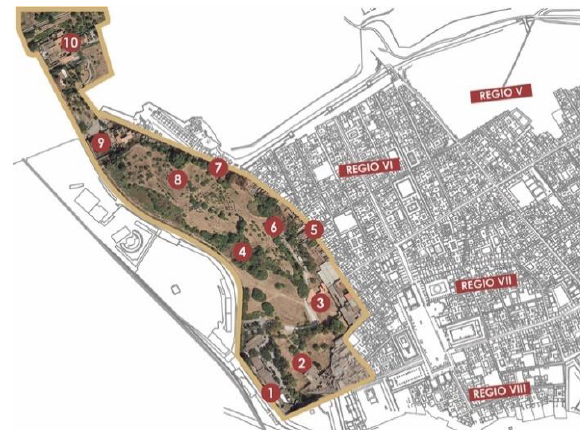
Figure 2. Framework of the Insula Occidentalis in the archeological area of Pompeii: 1. Superintendence offices and entrance of Porta Marina; 2. Suburban Thermal Baths; 3. Casa del bracciale d’oro and a «rest area»; 4. Bourbonic piles; 5. Palazzina Fiorelli; 6. «wood»; 7. Tomba di Mamia; 8. Villa di Cicerone;